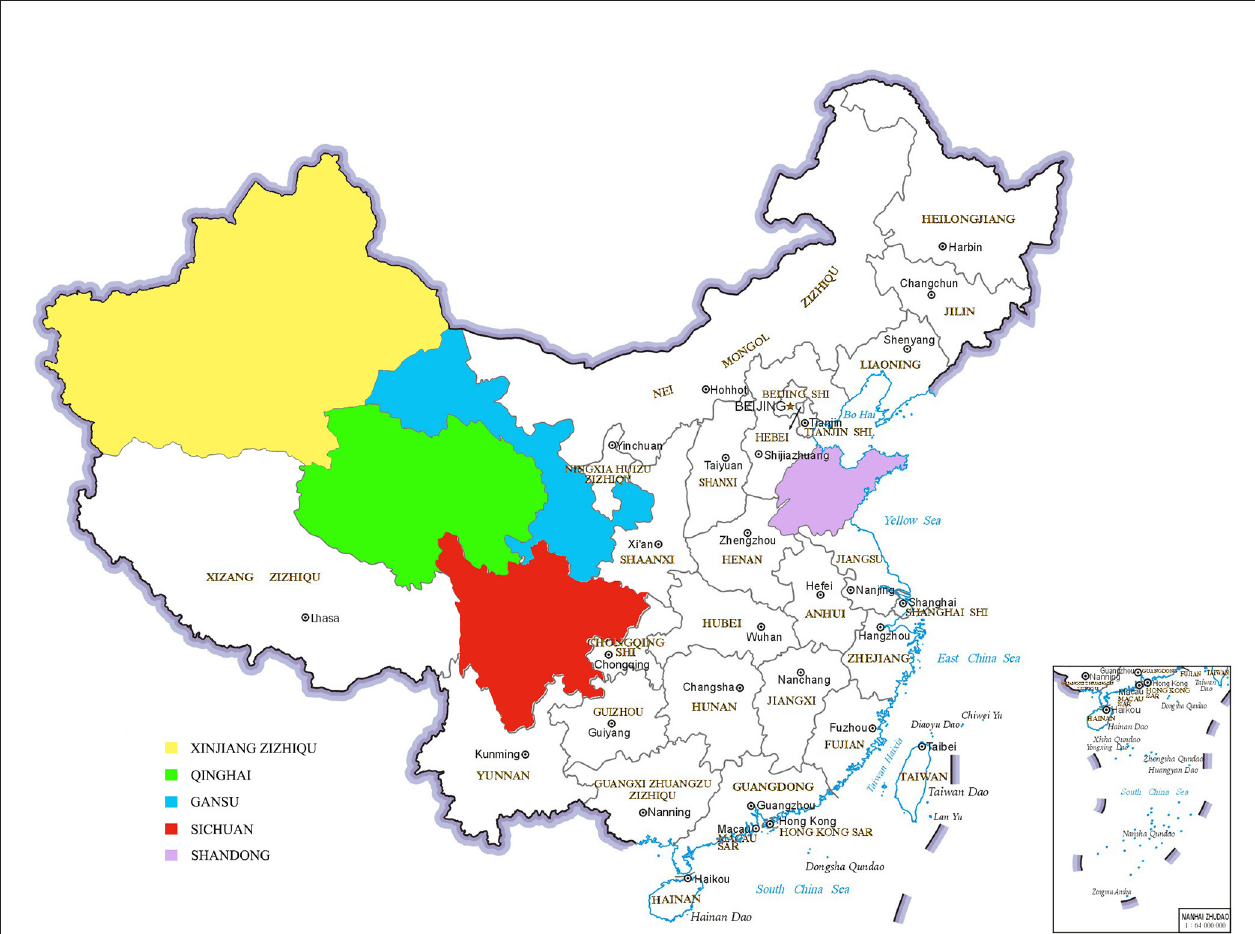
FIGURE 1 | Map identification of sampling locations (Yellow is Xinjiang, green is Qinghai, blue is Gansu, red is Sichuan and purple is